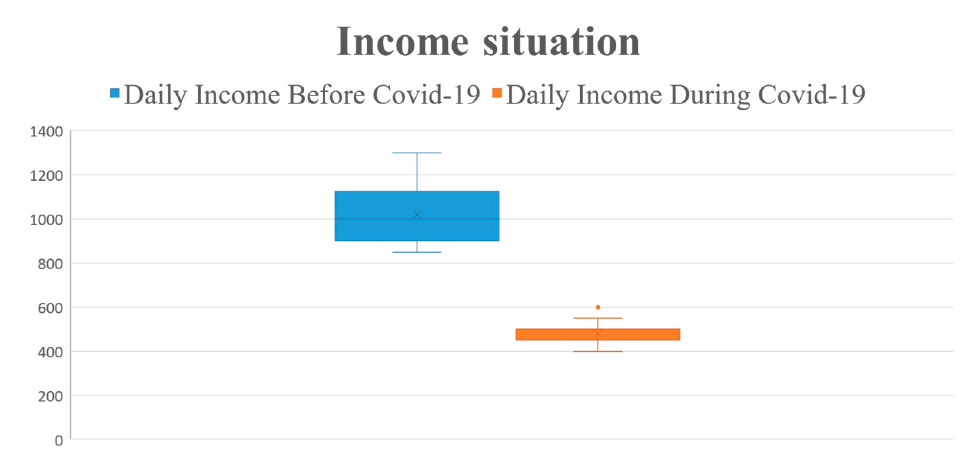
Figure 2. Daily average income of the easy-bike drivers.